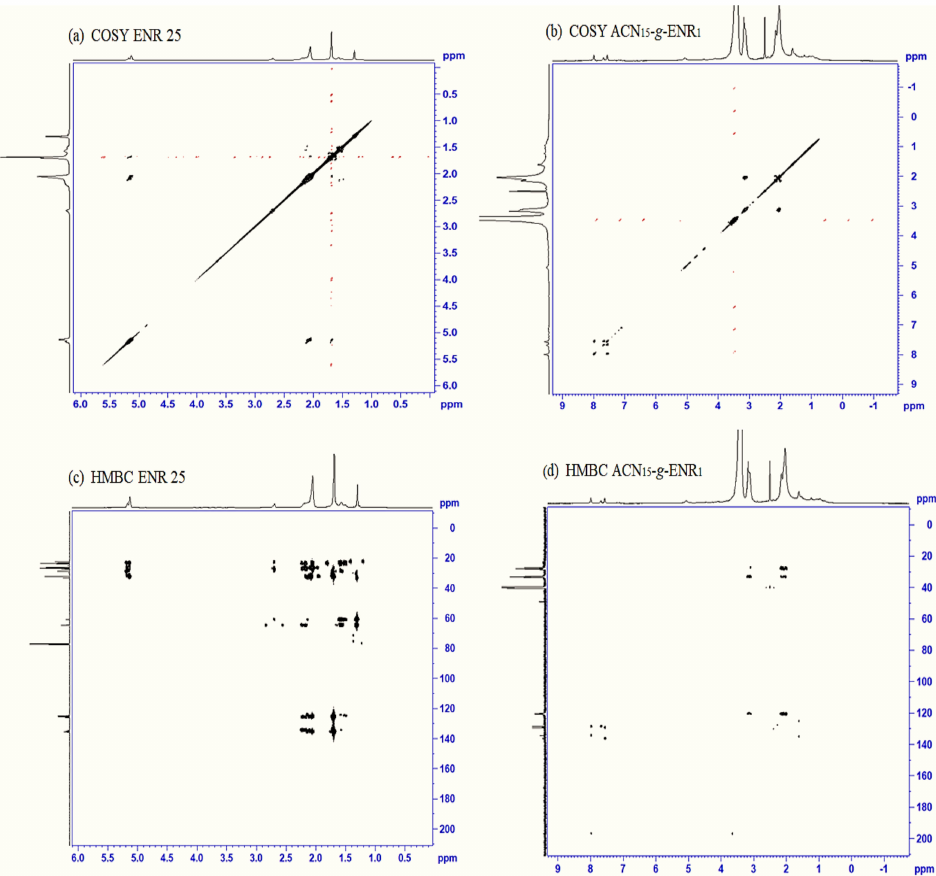
Figure 5. 2D NMR spectra for ENR- 25 and ACN 15 -g-ENR 1 : ( a ) COSY of ENR 25, ( b ) COSY ACN 15 - g-ENR 1 , ( c ) HMBC of ENR 25, and ( d ) HMBC of ACN 15 -g-ENR 1